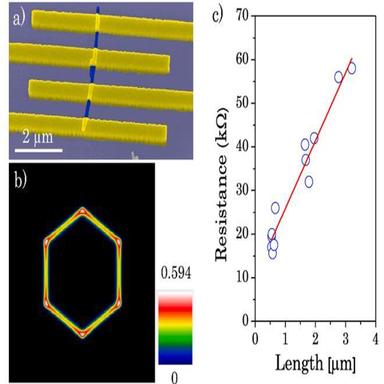
a) Artificially colored SEM image of a FET device, GaAs/InAs NW is the channel which is colored in blue, four Ti/Au leads are formed on the NW and colored in yellow, (b) A simulation of electron concentration distributed across the NW in which the InAs shell is 20 nm thick, the values of scale bar have unit of 1018 cm− 3 , (c) series resistance of the NW as a function of leads' spacing.